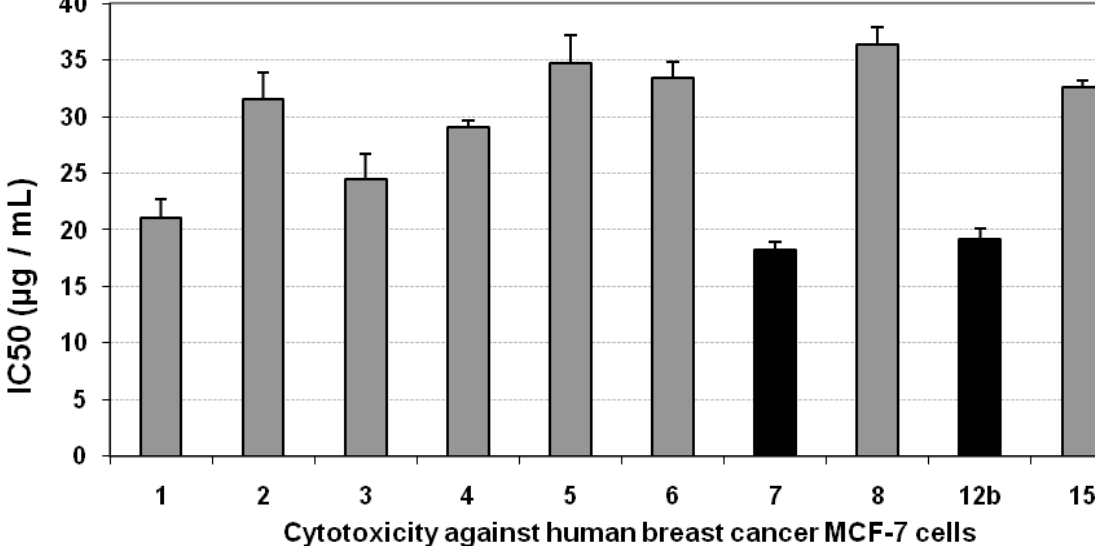
Figure 2. Cytotoxicity (IC , µg/mL) of different tested compounds against human MCF-7 50 cells 48 hours of incubation. The grey bars represent non-cytotoxic compounds, and the black bars represent the promising cytotoxic compounds. Data are representing mean value of IC ± 50